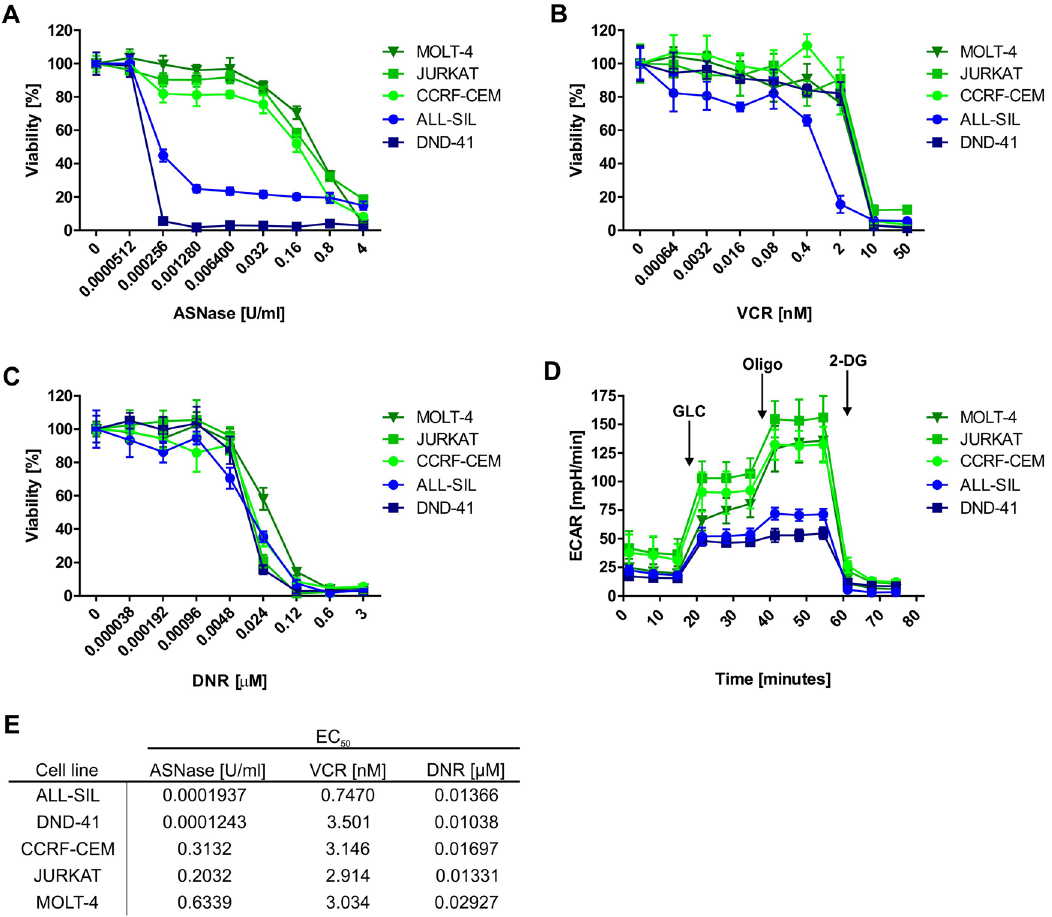
Figure 1. T-ALL cell lines: Sensitivity to cytostatic drugs and glycolytic profile. Sensitivity of T-ALL cell lines to ( A ) ASNase, ( B ) VCR and ( C ) DNR based on MTS assays. ( D ) Glycolytic profile of T-ALL cell lines